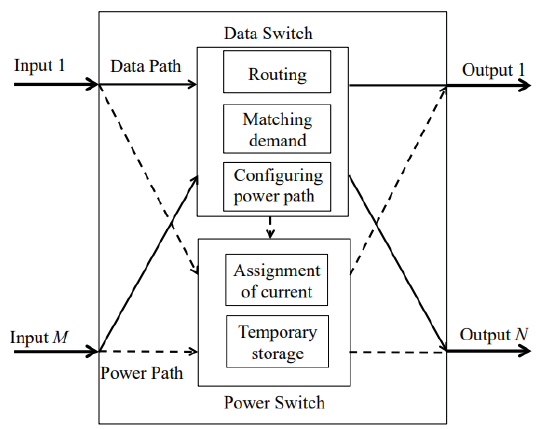
Figure 1. Architecture of a power router. Reproduced from [14]. Publisher: